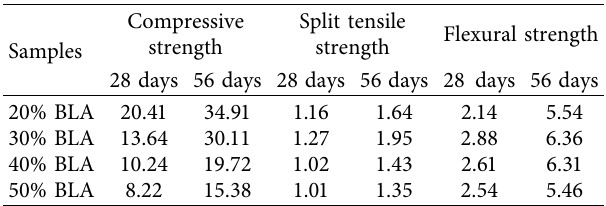
Figure 18: Effect of BNLA on mortar strength. (a) Compressive and (b) tensile [36]. Table 11: The effects of banana leaves’ ashes on compressive, tensile, and compressive strength of concrete